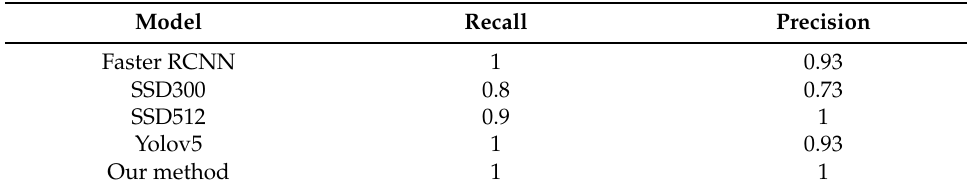
Table 4. Comparison with SOTA under video-level setting.